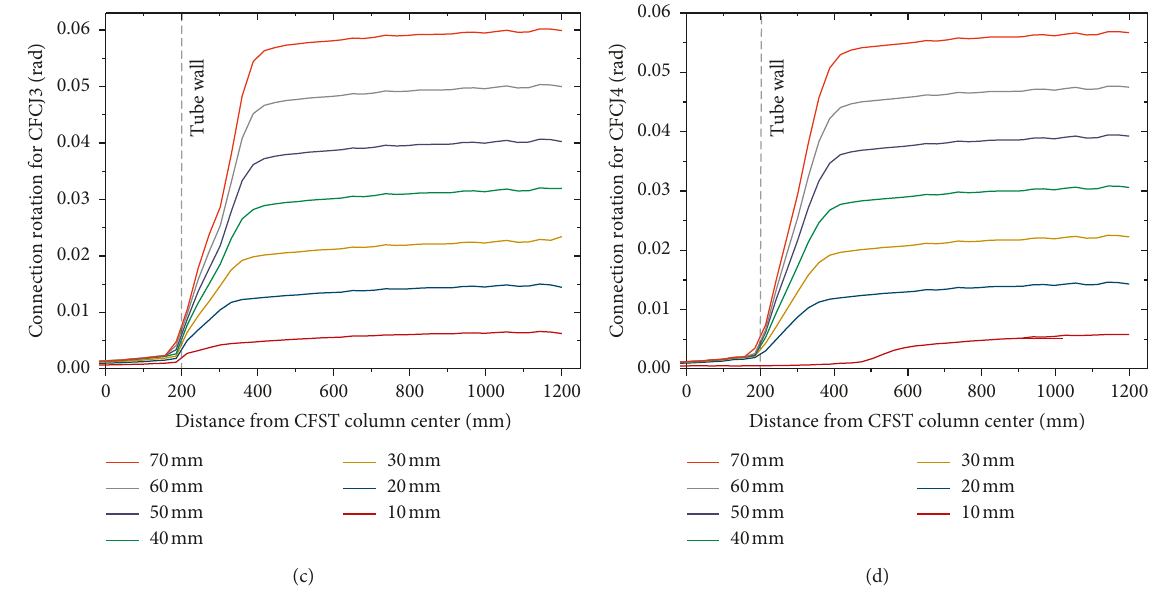
Figure 15: Distribution of connection